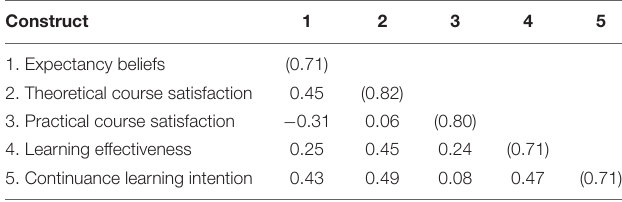
TABLE 4 | Discriminant validity